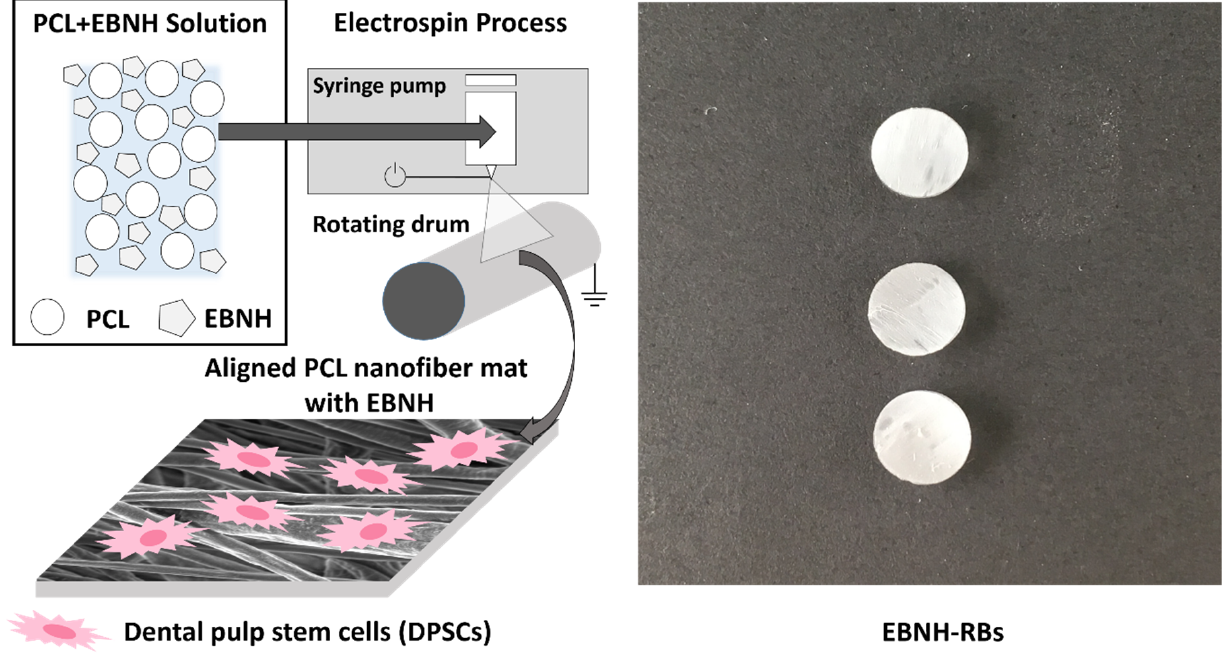
Figure 1. Overall scheme of the research. Abbreviations: PCL, poly( ε -caprolactone), EBNH, equine bone-derived nanohy- droxyapatite.